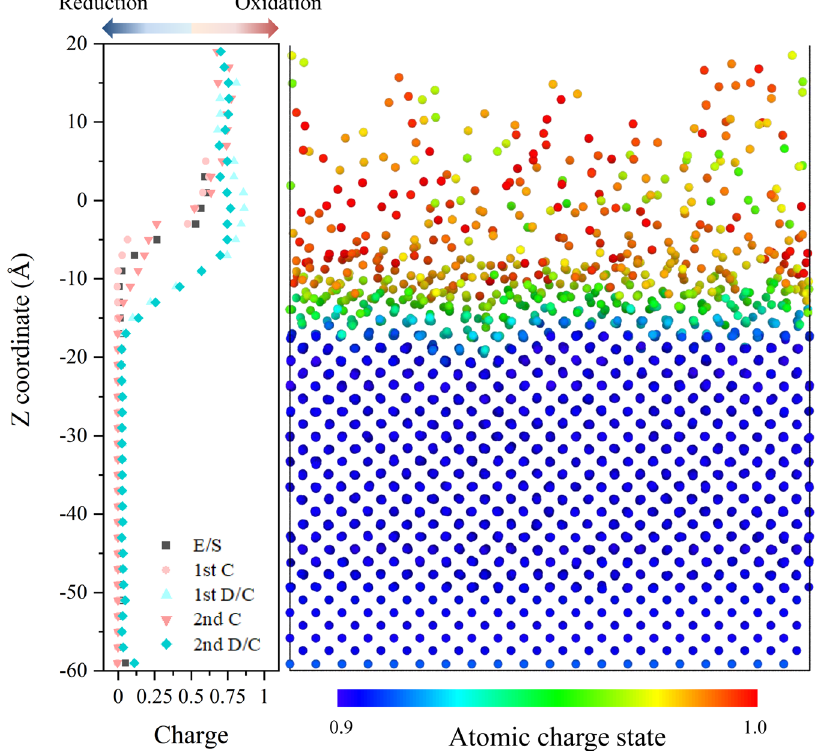
Fig. 3 Charge distribution of dissolved or re-deposited lithium ions from the anode surface during the cyclic charging/discharging (D/C) process. The right-hand panel shows the representative ionization state after the 1 st discharging